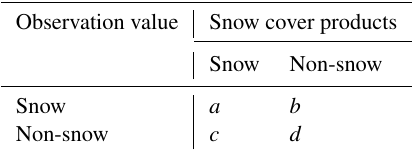
Table 1. Confusion matrix comparing snow cover products with observation